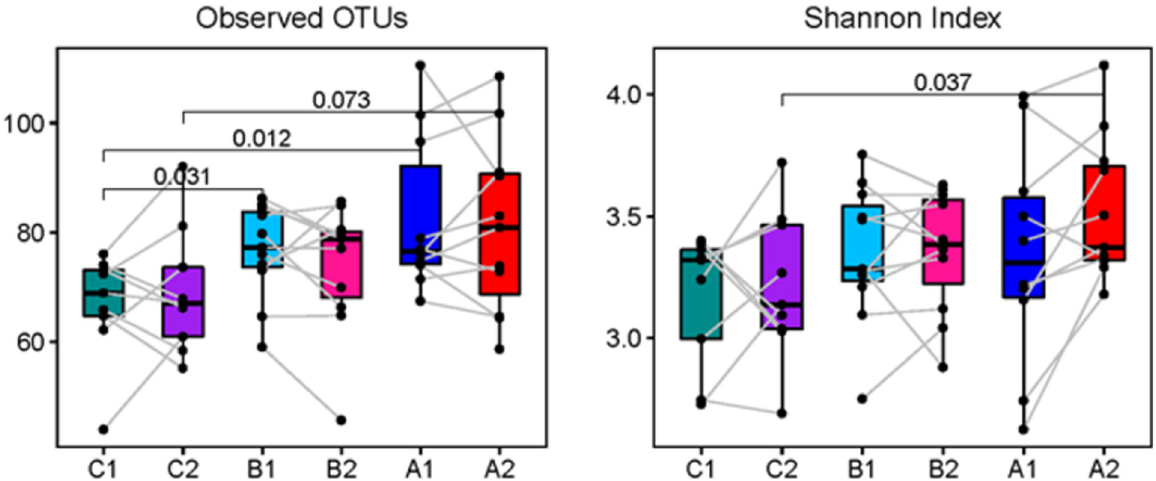
Fig 3. Microbial diversity expressed as observed OTUs and Shannon index. Box plots representing the observed OTUs and Shannon index are shown for each treatment group and time point. P -values for significant or nearly significant differences between groups are shown. The points with a connected line represent samples from the same individual at the two time points. A1 = Group A (fermented vegetable) at week 0; A2 = Group A (fermented vegetable) at week 6; B1 = Group B (pickled vegetable) at week 0; B2 = Group B (pickled vegetable) at week 6; C1 = Group C (control) at week 0; C2 = Group C (control) at week